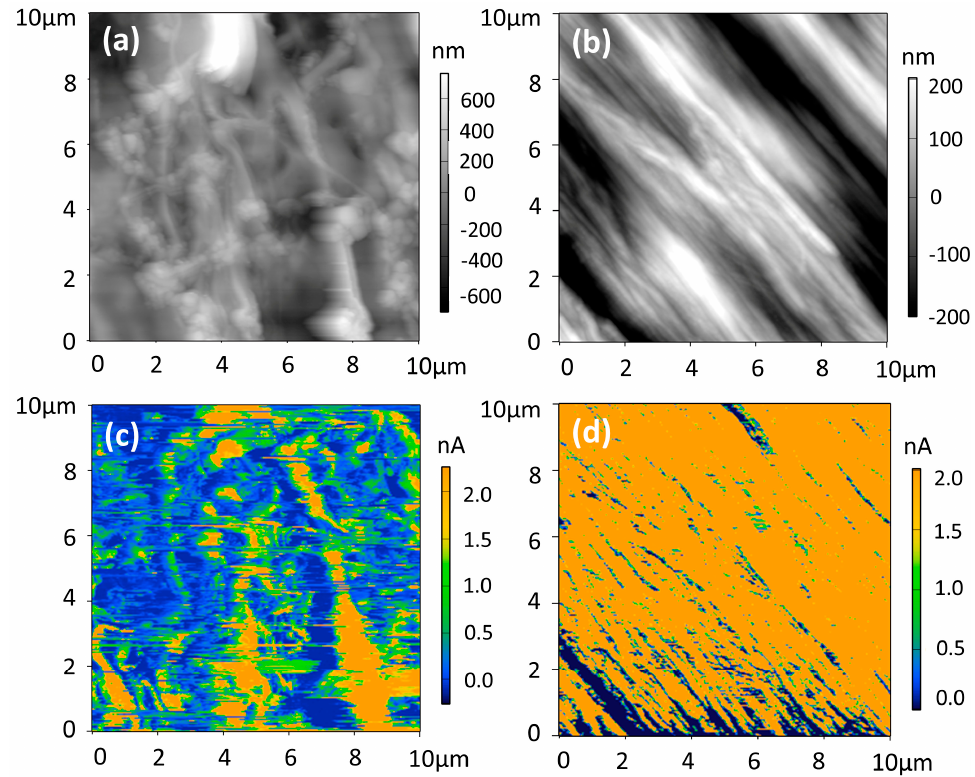
Figure 7. Conductive atomic force microscopy (C-AFM) mapping images. ( a ) Surface topography of ra-P3HT-TCB; ( b ) Surface topography of rg-P3HT-TCB; ( c ) Current image of ra-P3HT-TCB, and ( d ) Current image of rg-P3HT-TCB. The scanning voltages are 0.1 V.